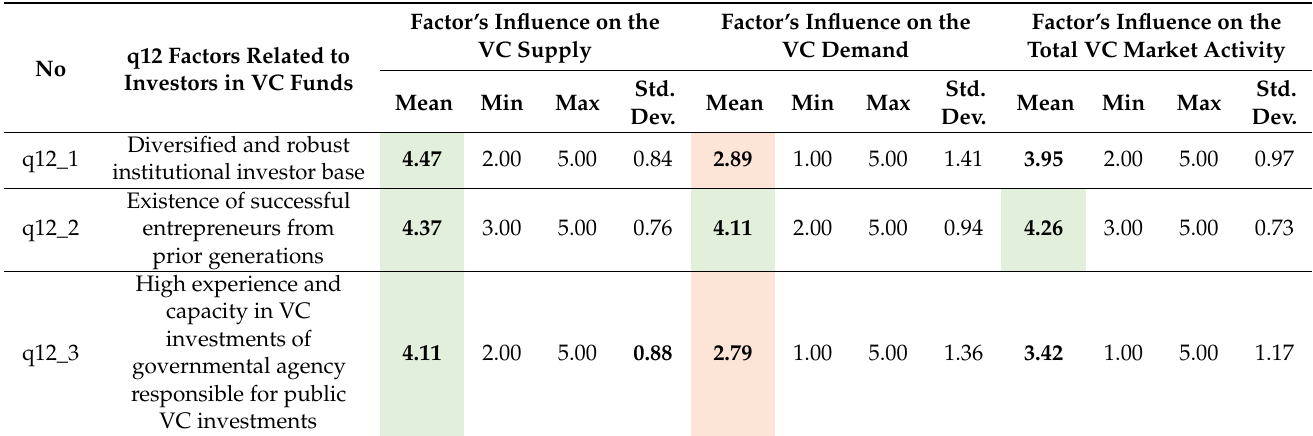
Table 9. The subfactors related to investors in VC funds